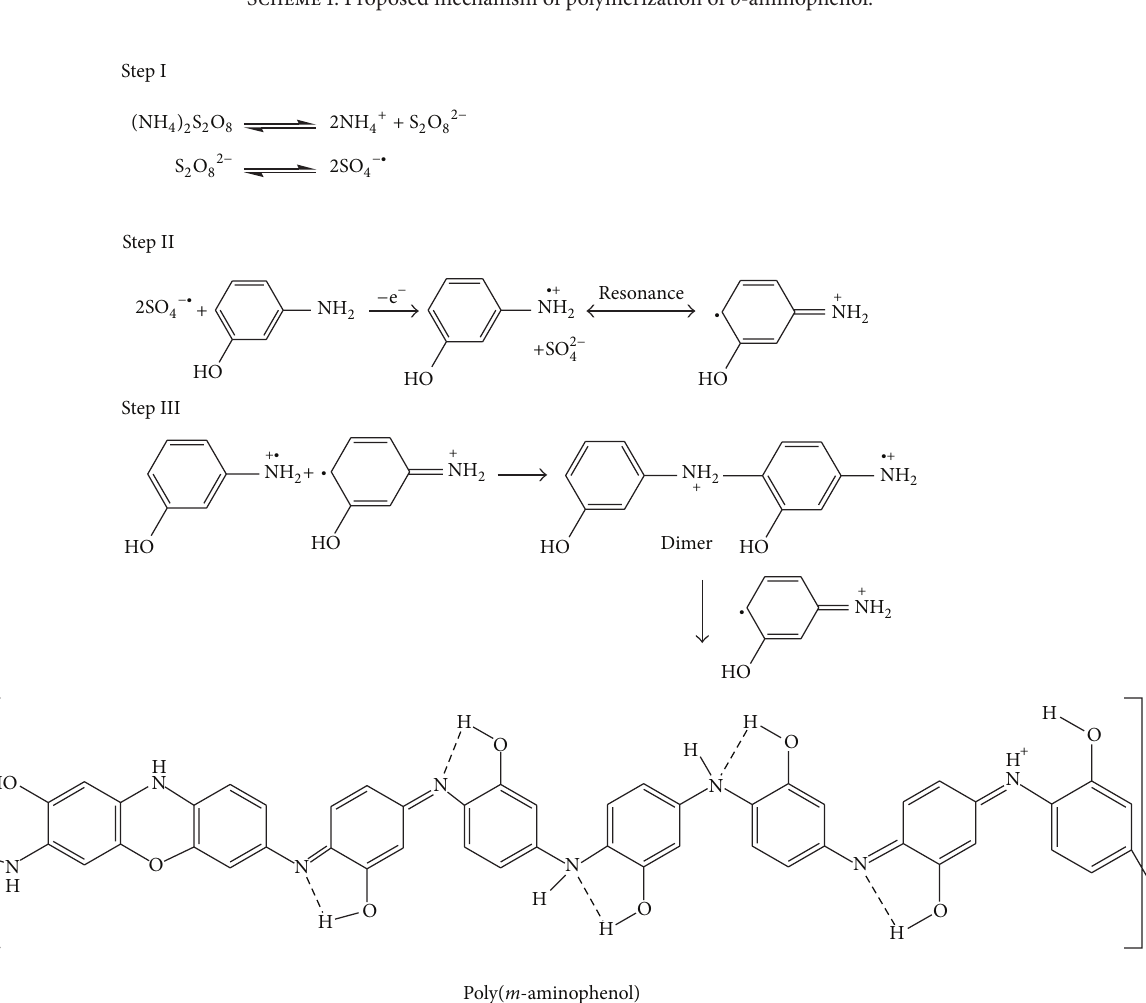
Scheme 1: Proposed mechanism of polymerization of o -aminophenol.